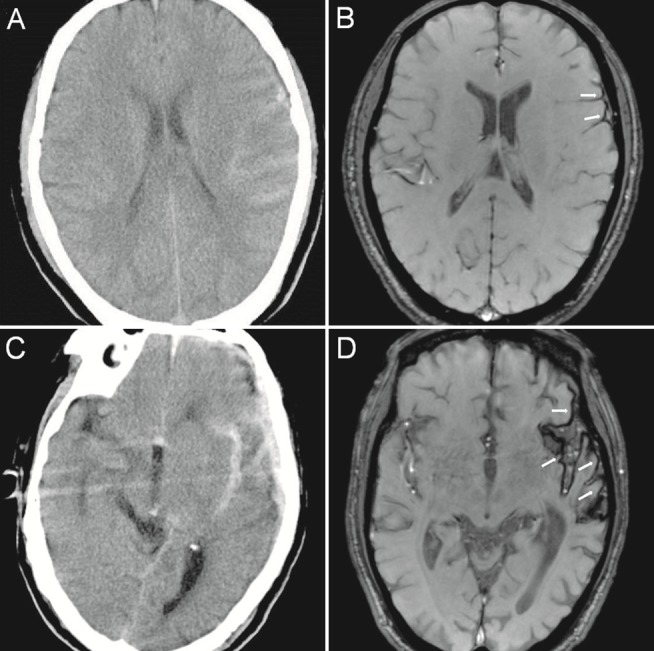
CT and ESWAN images of the brain of a 50-year-old man (A, B) and a 59-year-old man (C, D).The Fisher grades of the SAH based on the CT images were grade 2 (A) and grade 4 (C), respectively. Follow-up MR (1.5T) images were obtained at 34 weeks (B) and 177 weeks (D) after the head injury. The arrows denote areas of SS-CNS, which is indicated by a rim of hypointensity on the surface of the brain. Note the extent of deposition in each case. The CT and ESWAN images display a degree of correlation, patients with a higher Fisher grade exhibit more regions containing SS-CNS deposits.